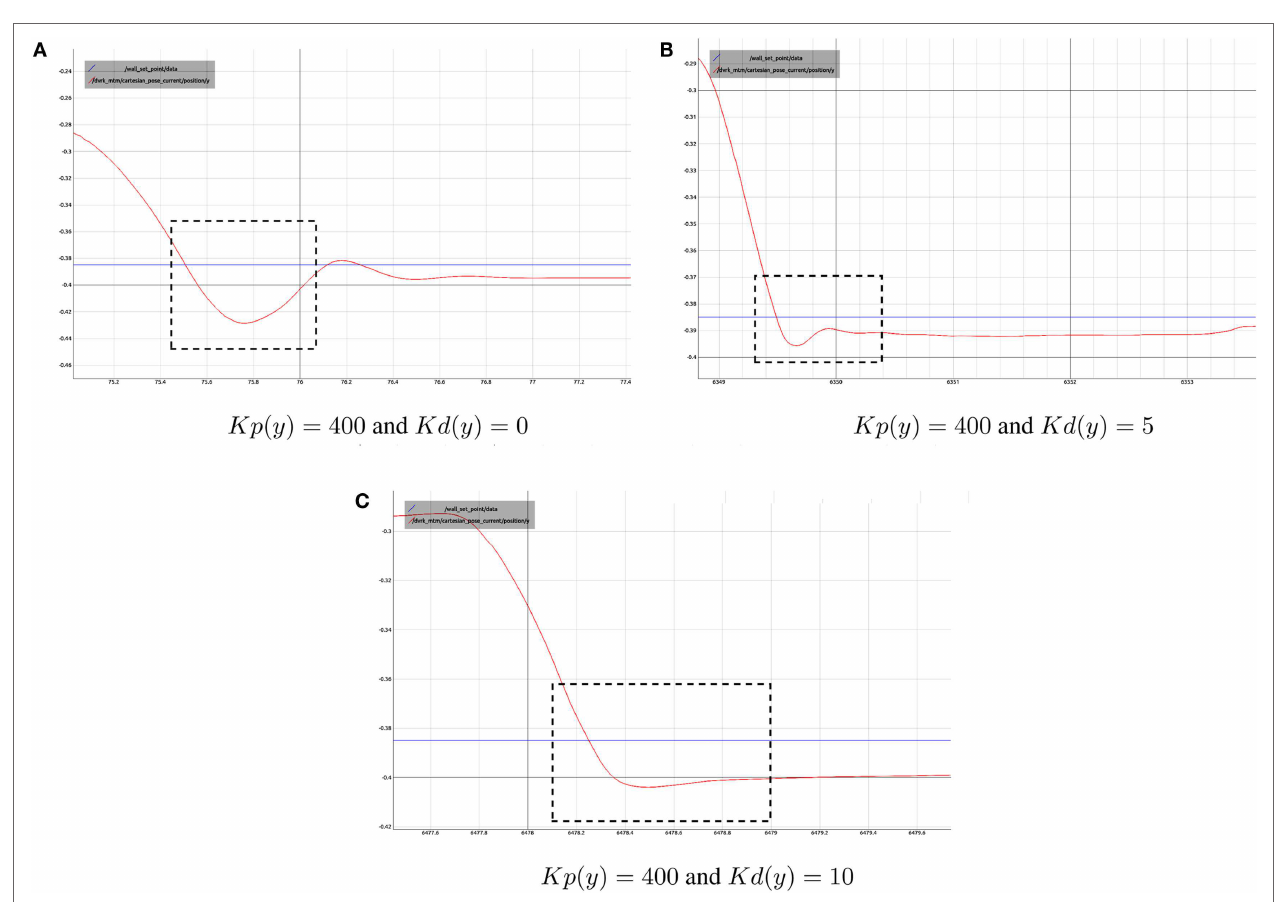
FIGURE 13 | A plot of current MTM Position along y axis when interacting with a wall in the x , z plane located at y = 0.385m . (A–C) show the controller performance for different values of Kp and Kd